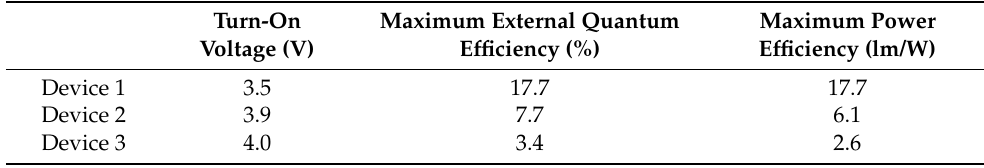
Table 2. EL characteristics of devices 1, 2, and